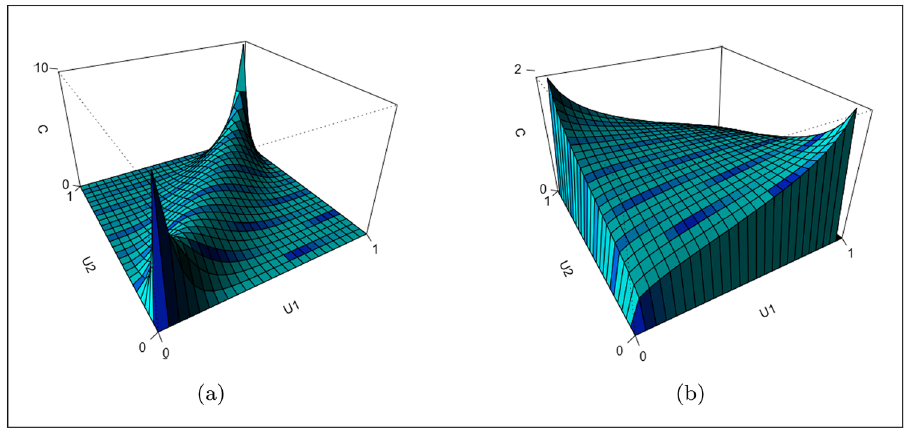
Figure 1: Gaussian copula density functions with di ff erent values of ρ : ( a ) = ρ 0.9 and ( b ) = ρ −0.25